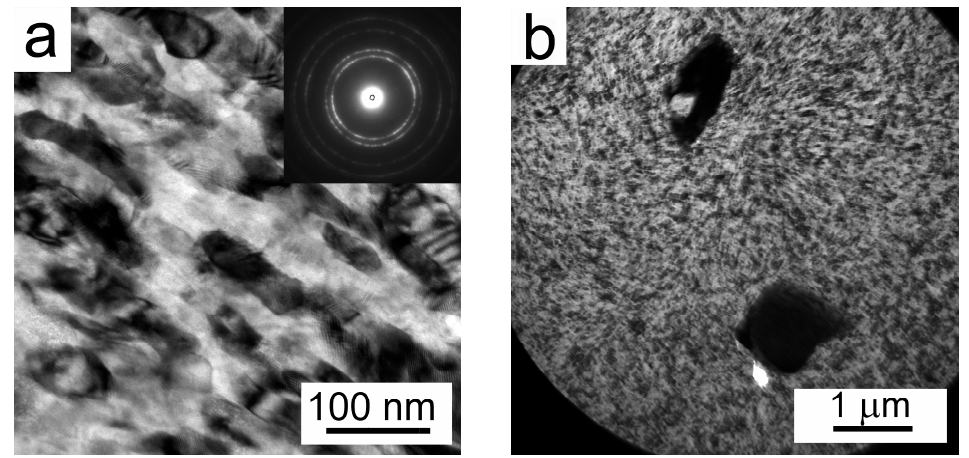
Figure 8. TEM images of the microstructure of a milled powder particle Al7075Zr_M, ( a ) elongated grains and ( b ) NiTi and Ti particles embedded in matrix.